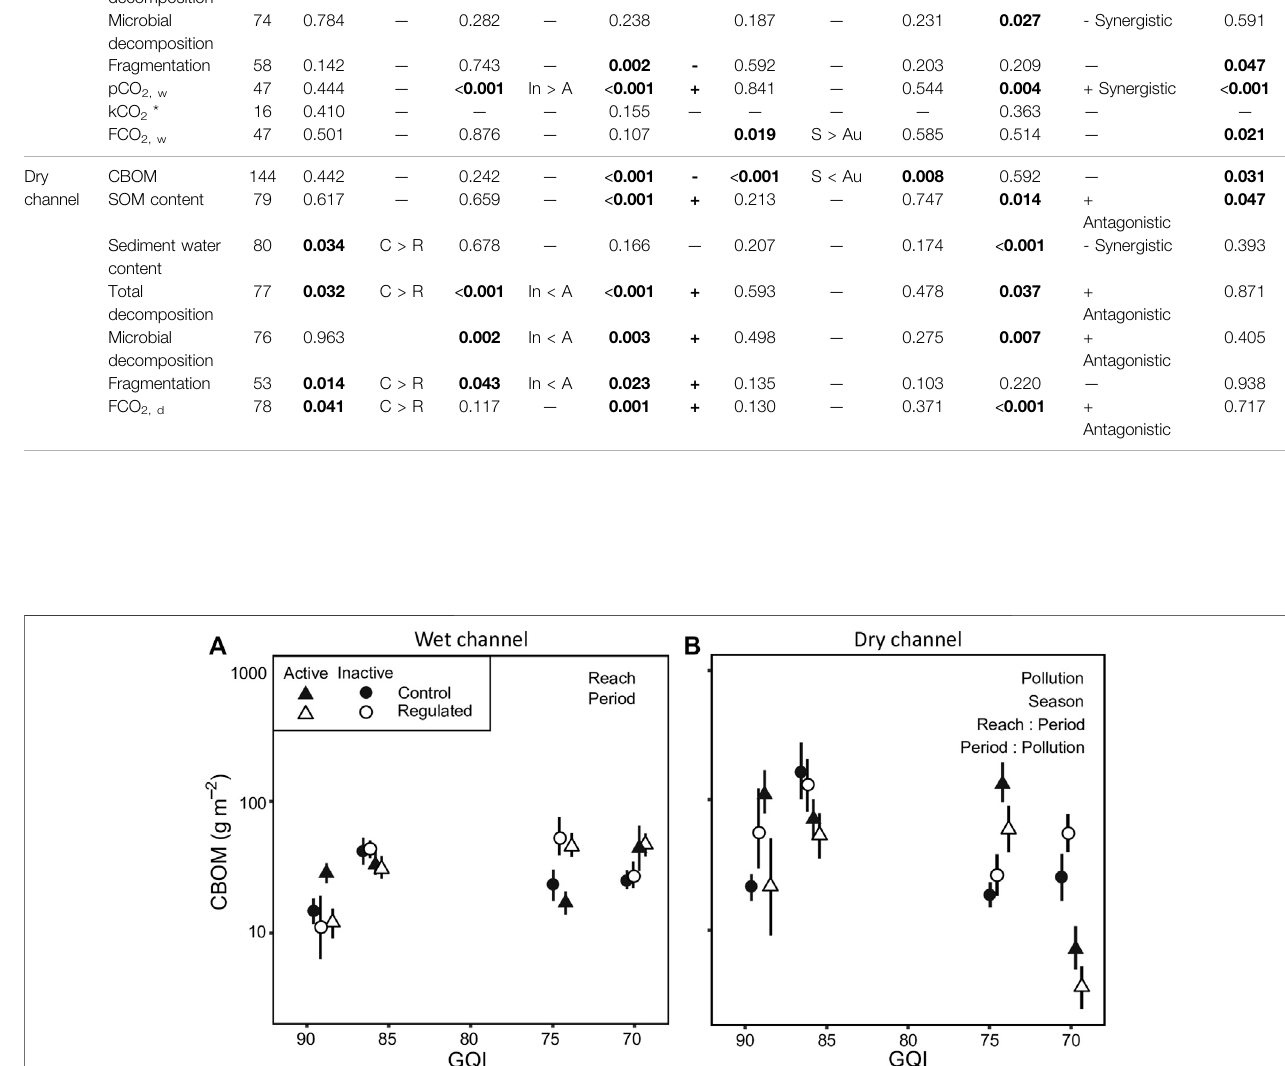
Frontiers in Environmental Science |